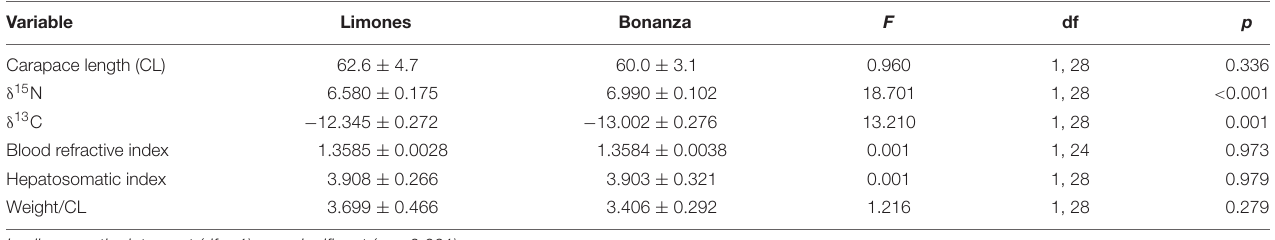
TABLE 4 | Results of General Linear Models testing for effects of reef habitat (Limones, Bonanza) on main response variables for Panulirus guttatus . Variable